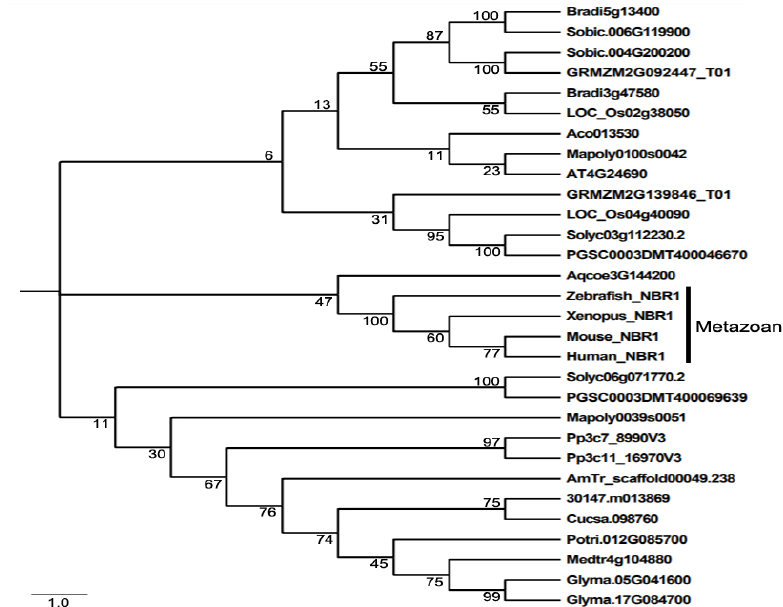
Figure 1. The phylogenetic relationship of NBR1 homologs from plants and metazoans. The tree was inferred using the neighbor-joining method. Phylogenetic analyses were conducted in MEGA5. Bootstrap values from 1000 replicates were used to assess the robustness of the tree. NBR1 homologs in the phylogenetic analysis include those from Homo sapiens (Human NBR1), Mus musculus (Mouse NBR1), Danio rerio (Zebrafish NBR1), Xenopus tropicalis (Xenopus NBR1), Marchantia polymorpha (Mapoly0100s0042 and Mapoly0039s0051), Physcomitrella patens (Pp3c7_8990V3 and Pp3c11_16970V3), Amborella